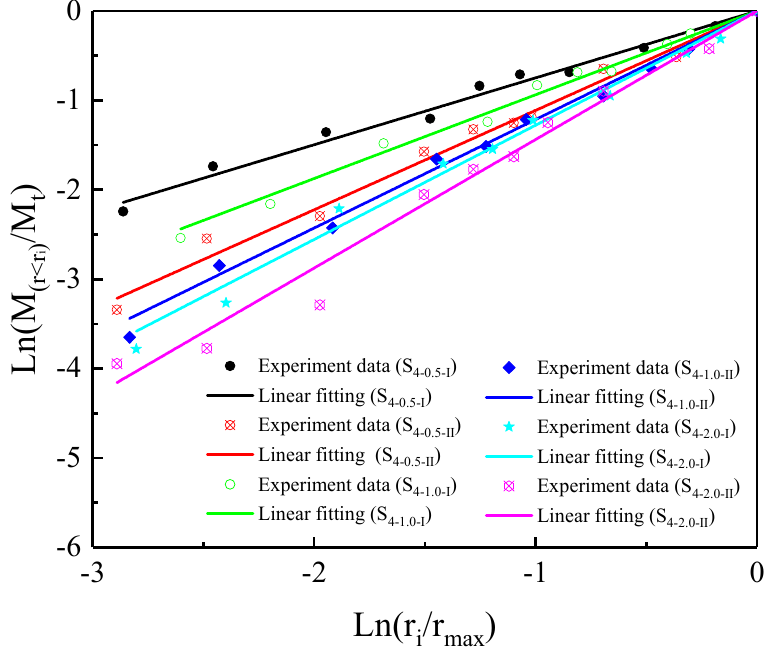
Figure 10. Fractal characteristics of fragments from S 4 series